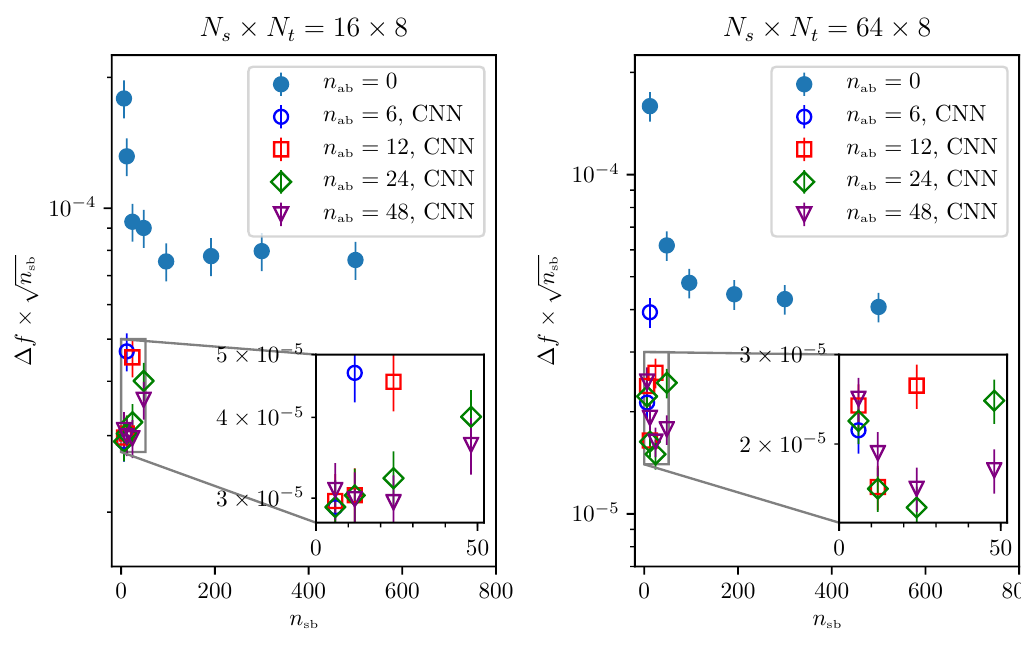
Figure 3 . Efficiency of various SNF architectures, determined as the error ∆ f times the square root of the number of stochastic blocks, for 16 × 8 lattices (left-hand-side panel) and 64 × 8 lattices (right-hand-side panel). Training time and measurements cost for the deterministic layers in SNFs are not taken into